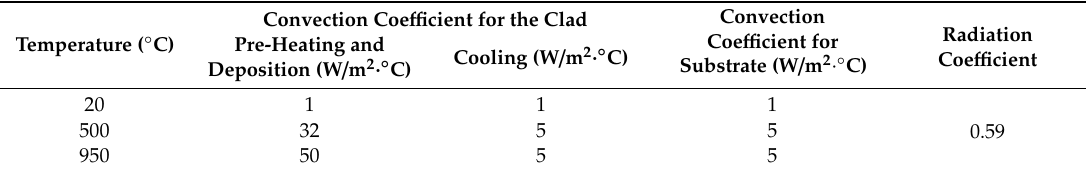
Table 3. Coe ffi cients of thermal boundary conditions for absorption factors ( β ) of 0.65 during preheating and 0.4 during deposition identified by inverse